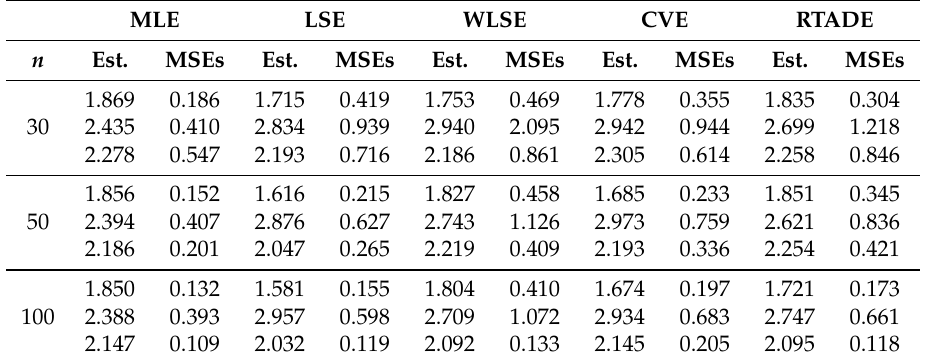
Table 4. Estimates and MSEs of TIHLIK model for ML, LS, WLS, CV, and RTAD estimates for the Set3, i.e., a = 1.5, λ = 3, b =